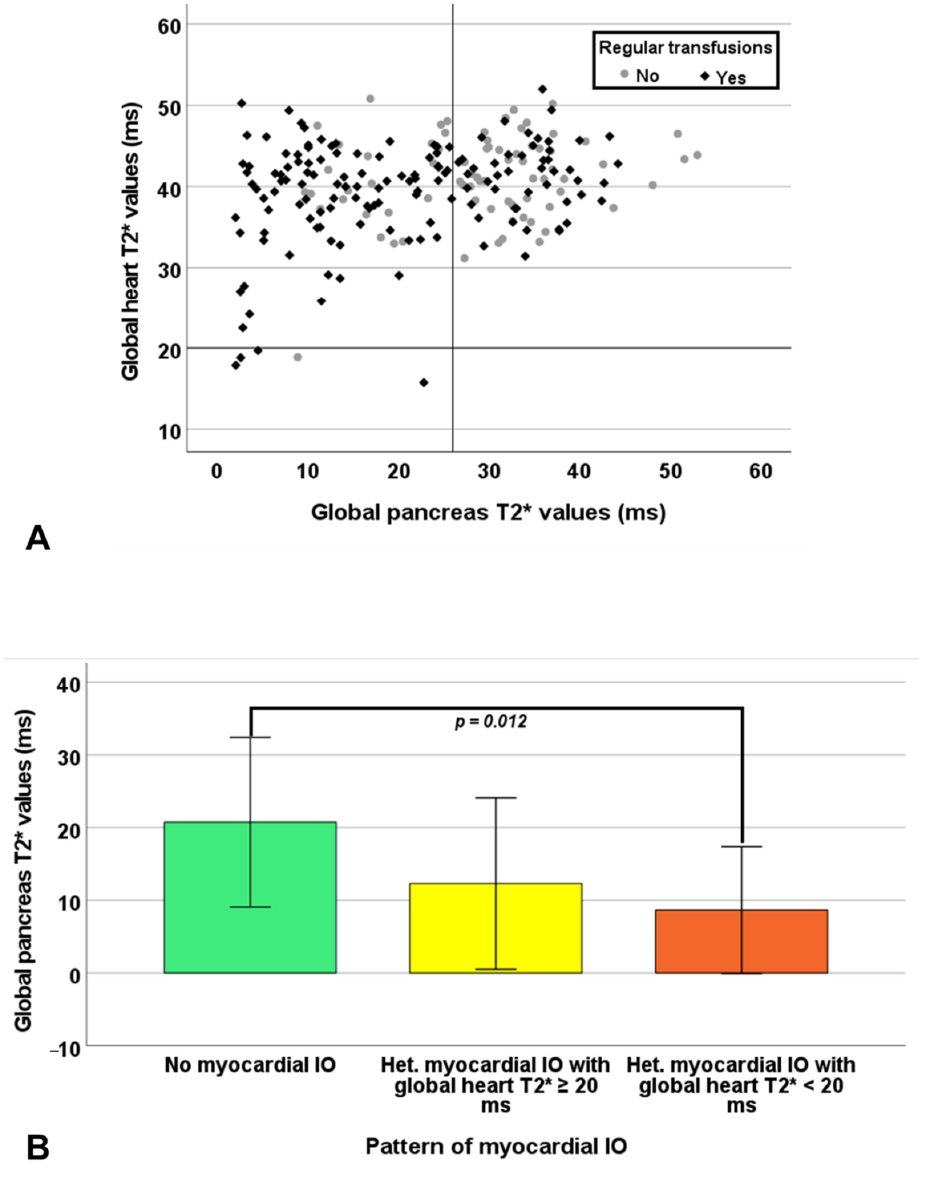
Figure 3. ( A ) Scatter plot of global heart T2* values versus global pancreas T2*values. The horizontal and vertical dotted lines represent the cut-off for T2* values. ( B ) Global pancreas T2* values in the groups of patients with different patterns of myocardial iron overload. LV and right ventricular (RV) end-diastolic volume indexes and ejection fractions and LV mass index were not correlated with global pancreatic T2* values.